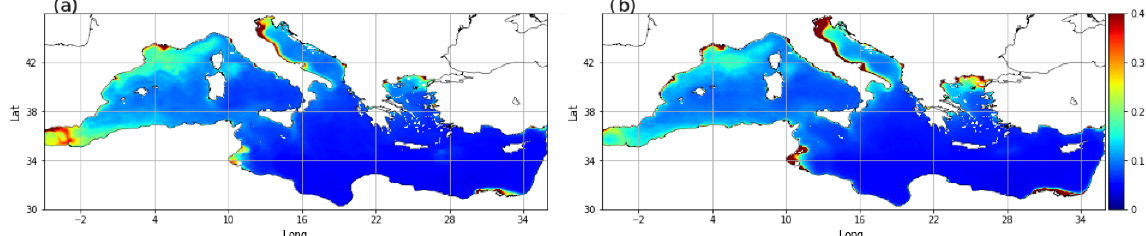
Figure 3. Averaged annual maps of surface chlorophyll (mgm − 3 ) from the qualification run (a) and from NRT multi-sensor satellite (b) .